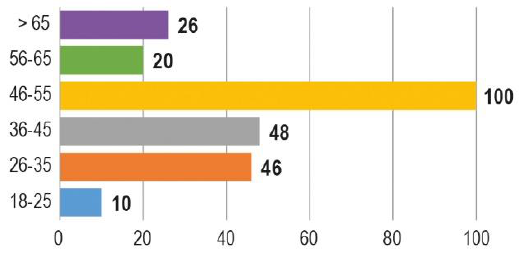
Figure 3. Age of respondents who consider CODs an effective measure to control stray dog populations ( n = 250).